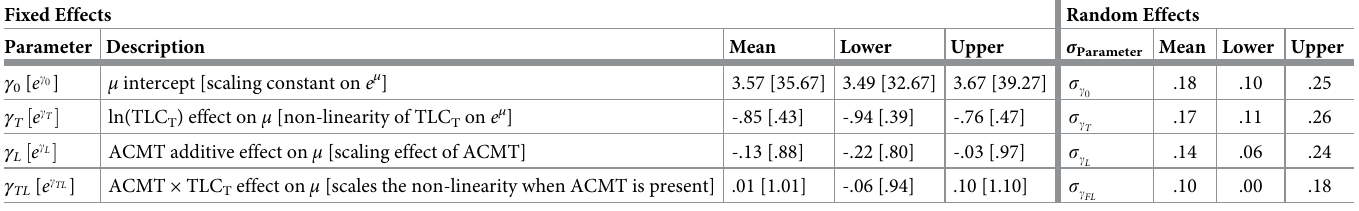
Table 2. Posterior means and 95% highest density intervals for parameters predicting the mean of ln(SWA Max ), μ . Fixed